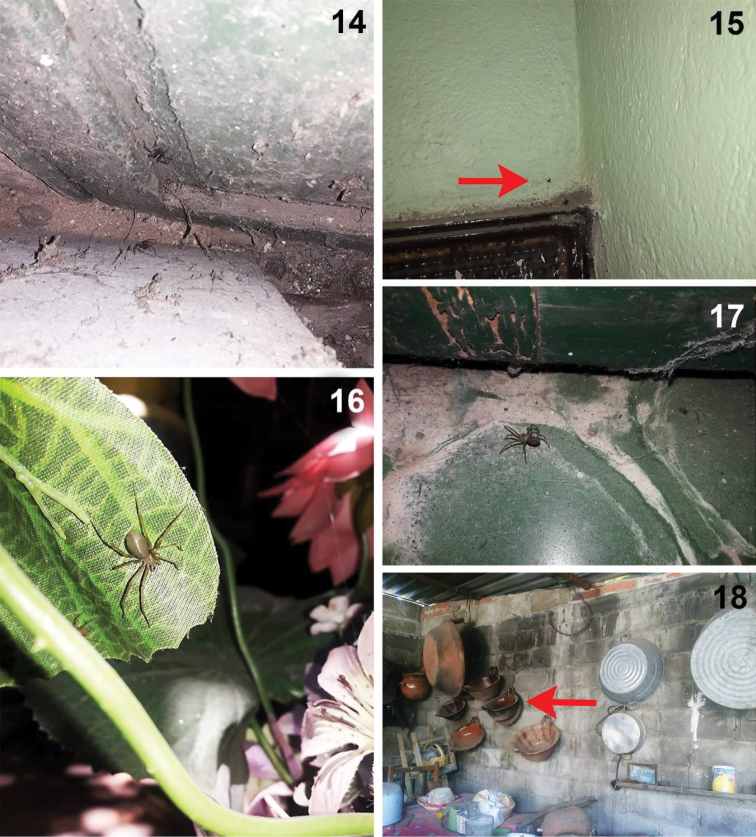
Live specimens and urban microhabitat of Loxosceles
tenochtitlan sp. nov. from Tlaxcala 14–17 specimens from Street Juárez Norte #214, Huamantla downtown, Municipality, Huamantla, Tlaxcala, Mexico 18 microhabitat where some specimens were collected from Street Reforma #5, Santiago Tlacochcalco, Municipality Tepeyanco, Tlaxcala, Mexico. Red arrows indicate the specific places where specimens were collected. Photographs 14–17 by José A. Castilla-Vázquez (2018–2019). Photograph 18 by Alma R. Juárez-Sánchez (2018).